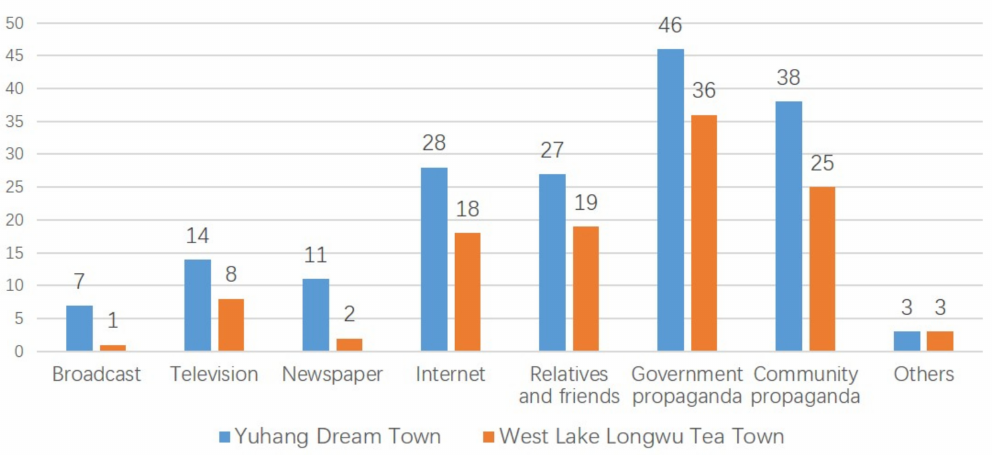
Figure 19. Selected frequency of the way for respondents to understand the development of local CTs (source: